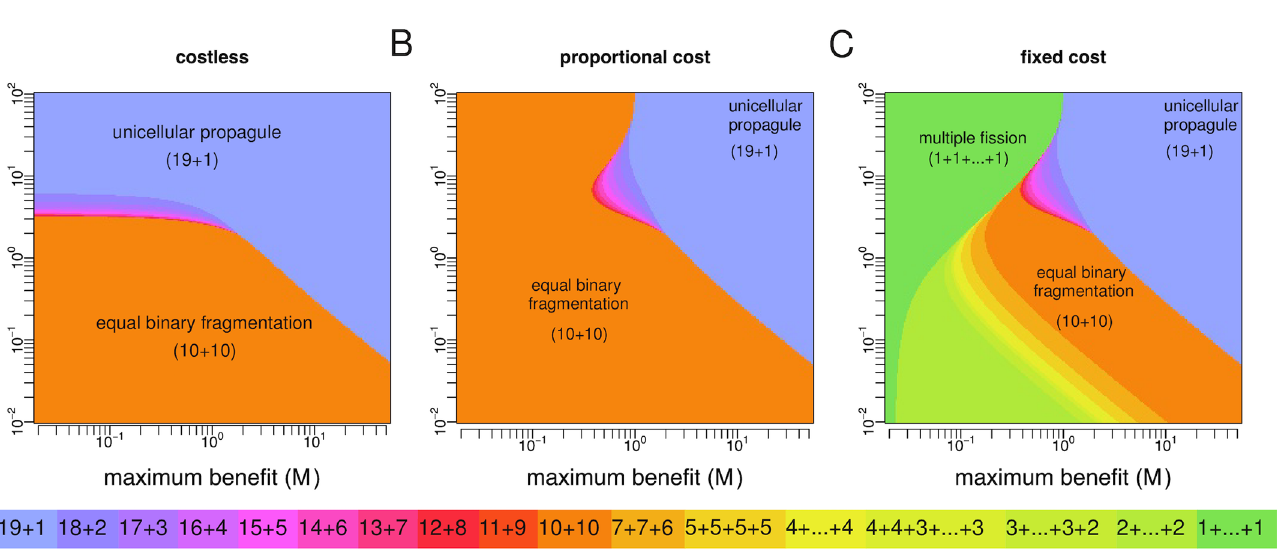
PLOS Computational Biology | https://doi.org/10.1371/journal.pcbi.1005860 November 22,